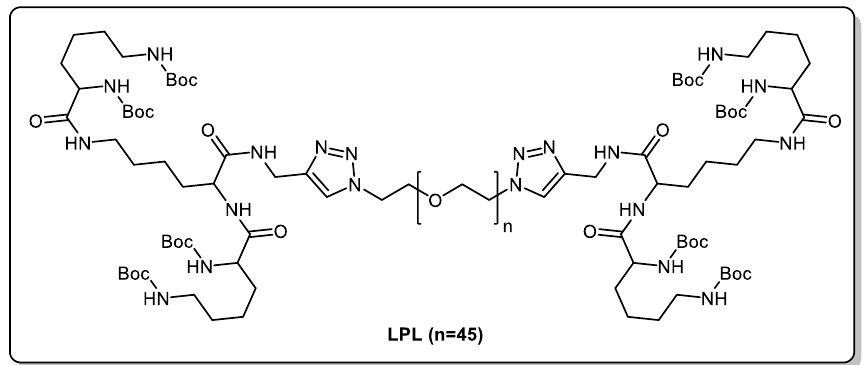
Figure 5. The chemical structure of LPL (n = 45) triblock copolymer.